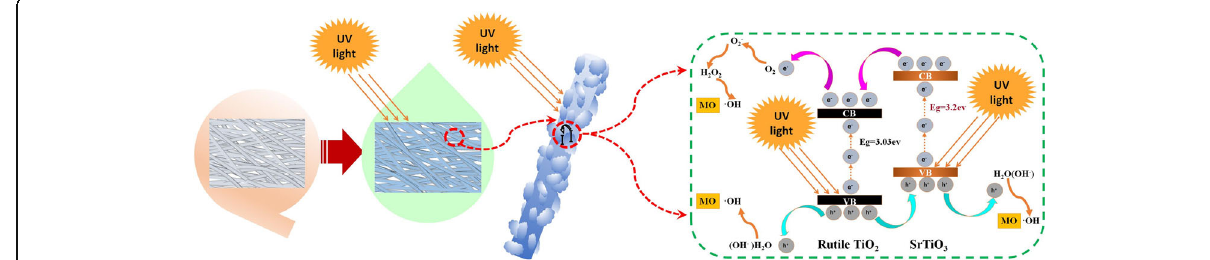
Fig. 6 A proposed mechanism for the photocatalytic degradation of MO by the SrTiO 3 / TiO 2